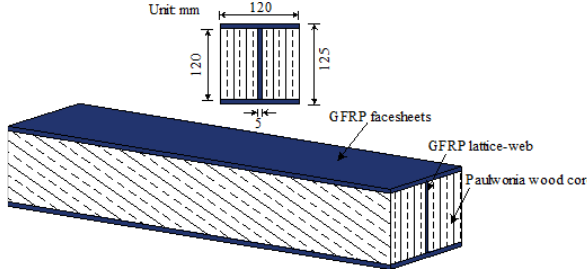
Figure 6: Sketch of the specimen web reinforced pawuownia wood sandwich panel.